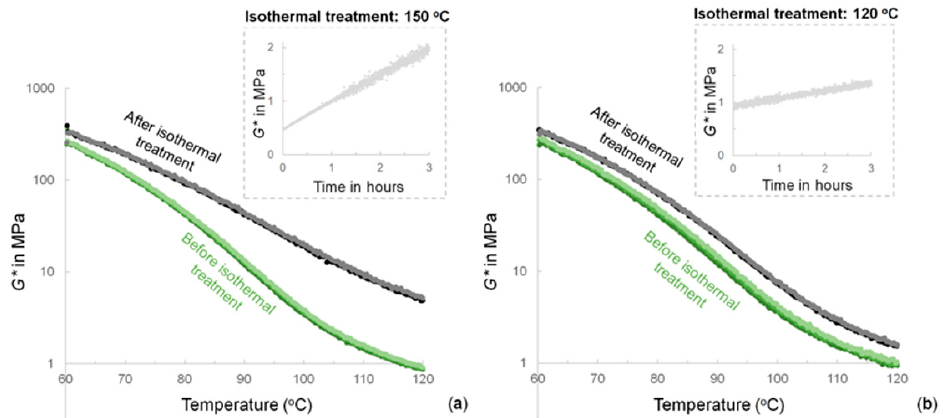
Figure 5. Thermo-mechanical profiles of the FM-TRCP before (three heating profiles in different tones of green) and after (two heating profiles in black and gray) isothermal treatments at ( a ) 150 °C and ( b ) 120 °C (insets). For simplicity, only the heating profiles are shown.